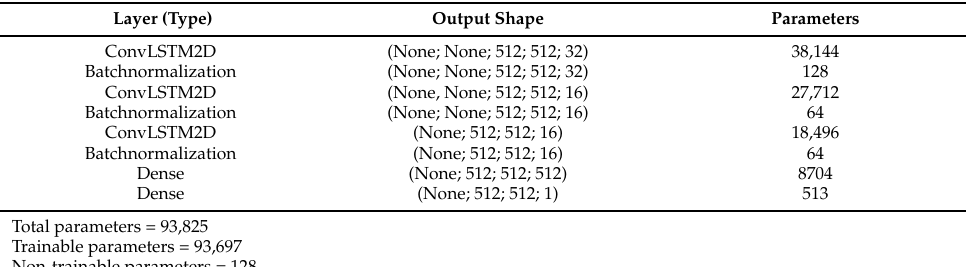
Table 10. Description of the ConvLSTM network layers.